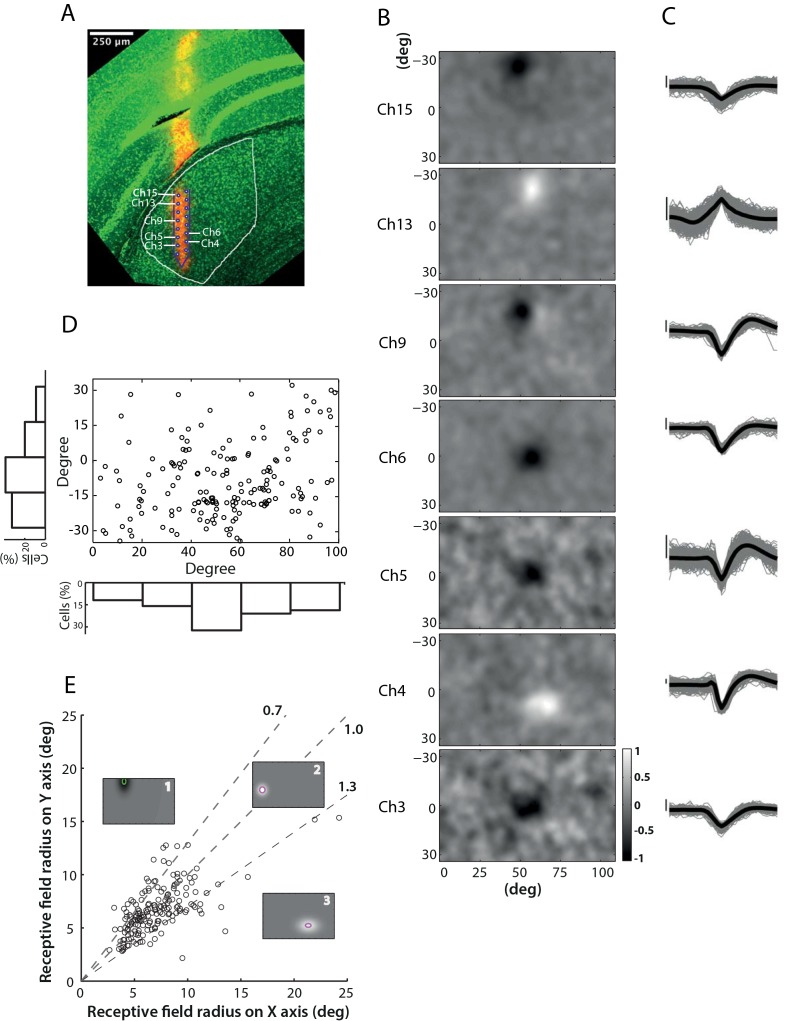
Spatial receptive field profiles of mouse LGN neurons.A) Confocal image of a coronal section of a brain slice (200 μm thickness). The electrode was dyed with DiI/DMSO solution (red track), and the slice stained with DAPI (Diamidino-2-phenylindole, displayed in green). The LGN boundary and electrode track within the LGN are delineated in white and purple respectively. Electrode sites corresponding to seven recorded neurons are labelled. B) 2D profiles of receptive fields from seven units reconstructed with the STA technique. The colour map in grey-scale shown at the bottom right indicates the intensity of the response of each unit to the contrast-noise movie (see Methods). MEA channel labels correspond to those in the histological image (A). C) Spike waveforms for the neurons shown in (B). Vertical scale bars indicate 25 mV. D) Receptive field centre location for all units in the dataset. The main panel displays the receptive field location of each cell within the visual display, with histograms at left and bottom showing the distributions of receptive field locations on the vertical and horizontal axis respectively. E) Correlation between receptive field radius vertical and horizontal components. Three single-cell representatives show cells whose receptive field fell into the three categories respectively: larger size on the vertical axis (1), circular (2) and larger size on the horizontal axis (3).